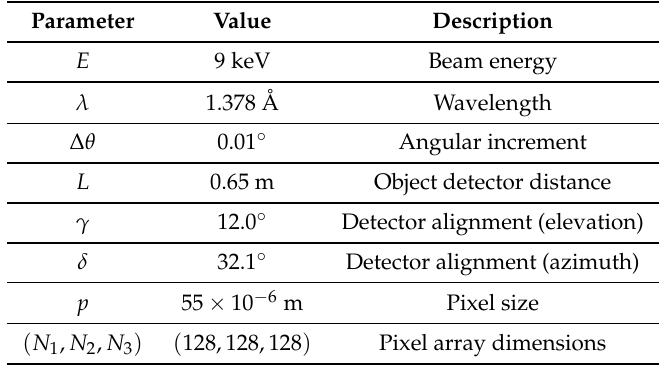
Table A1. Parameters of the simulated BCDI forward model. Refer to Figure 2 for the experimental geometry.